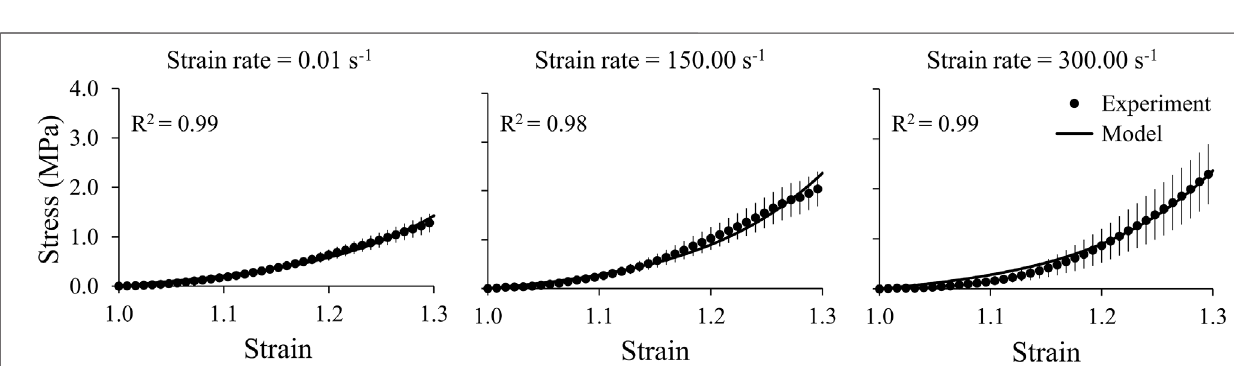
FIGURE 4 | A one-term Ogden hyperelastic, one-term Prony series model (solid lines) fi t to the average experimental stress-strain behavior (circles) for three brain regions(cerebrum,cerebellum,andbrainstem),eachatthreestrainrates(0.01,150.00,and300.00s -1 ).Thecirclesandverticallinesrepresentthemean( n (cid:1) 6)andone standard error of the mean, respectively.